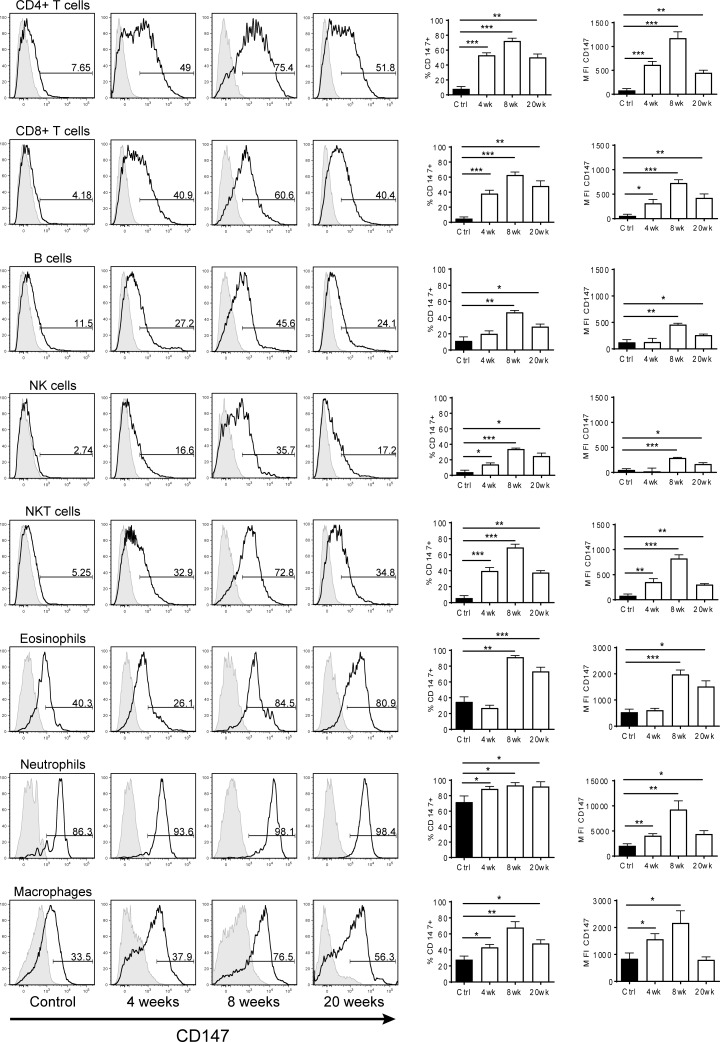
CD147 surface expression on leukocyte subsets isolated from livers in progressive liver injury.Flow cytometry was performed on liver leukocytes from control and TAA-treated mice. Each leukocyte subset was analysed for expression of CD147 and data recorded as the percentage of cells positive for CD147 (%CD147+) or mean fluorescence intensity (MFI). Representative histogram plots are shown for each subset, where the black histogram represents the indicated liver subset and grey histogram indicates isotype control. Bar graphs represent mean ± SEM Mann-Whitney test was performed to assess significance from control where * p<0.05, **p<0.01, ***p<0.001 (n = 5–8 per group).